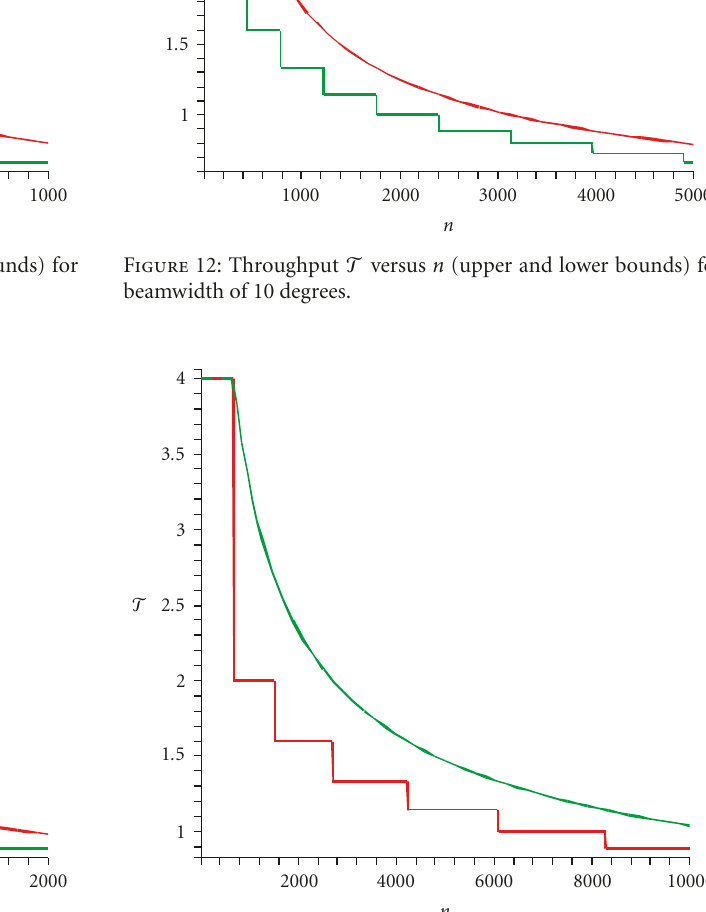
Figure 13: Throughput T versus n (upper and lower bounds) for beamwidth of 5